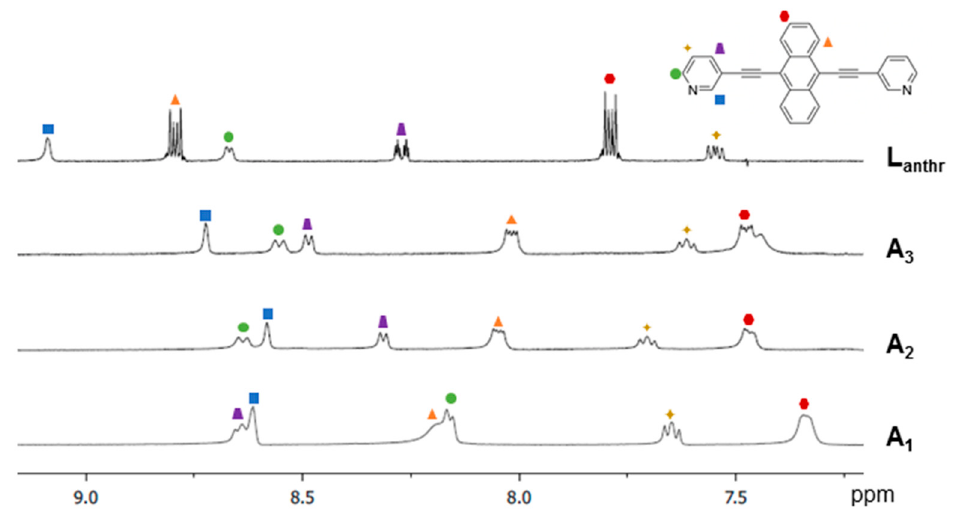
Figure 3. 1 H NMR spectra of the aromatic region of L anthr , A 3 , A 2 and A 1 (acetone- d 6 , 23 °C).